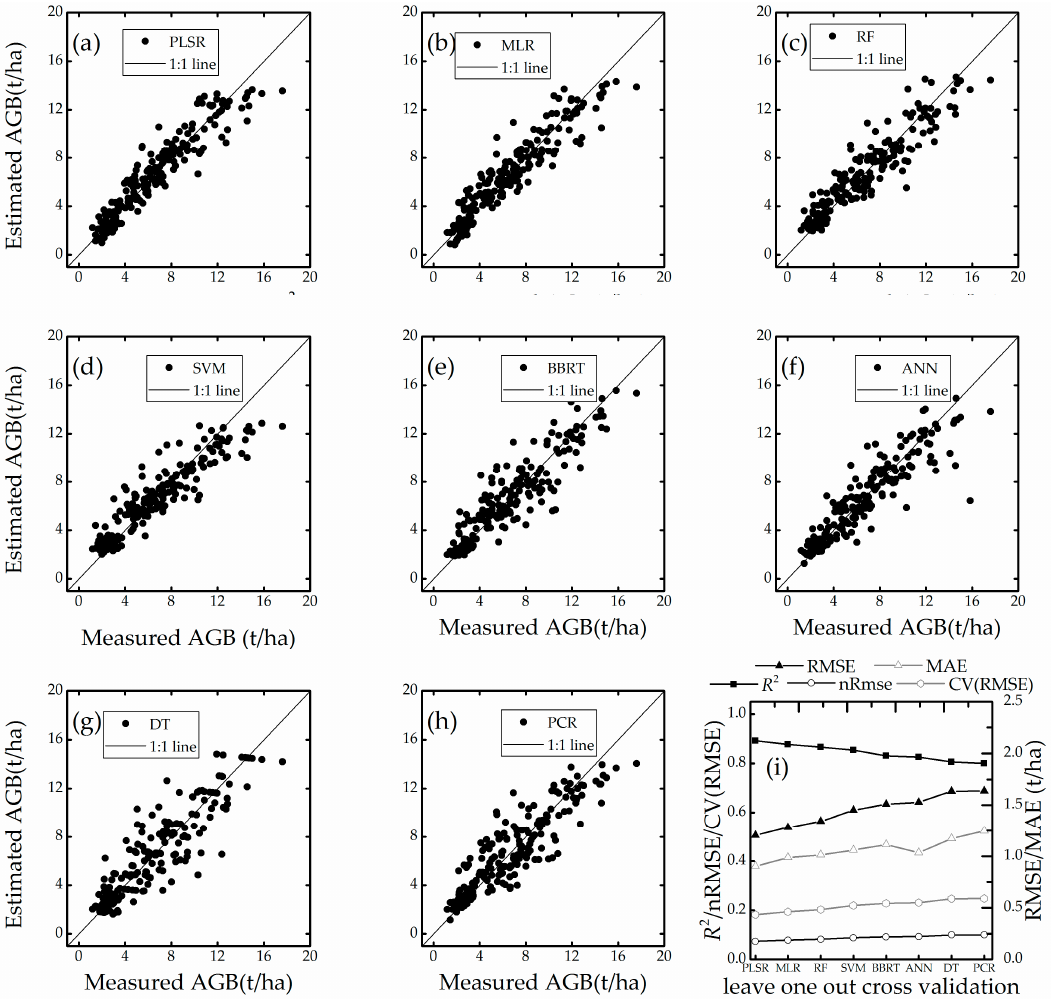
Figure 10. Measured and estimated AGB using leave one sampling. ( a ): PLSR; ( b ): MLR; ( c ): RF; ( d ): SVM; ( e ): BBRT; ( f ): ANN; ( g ): DT; ( h ): PCR; ( i ): R 2 , RMSE, MAE, NRMSE and CV(RMSE) of all techniques.